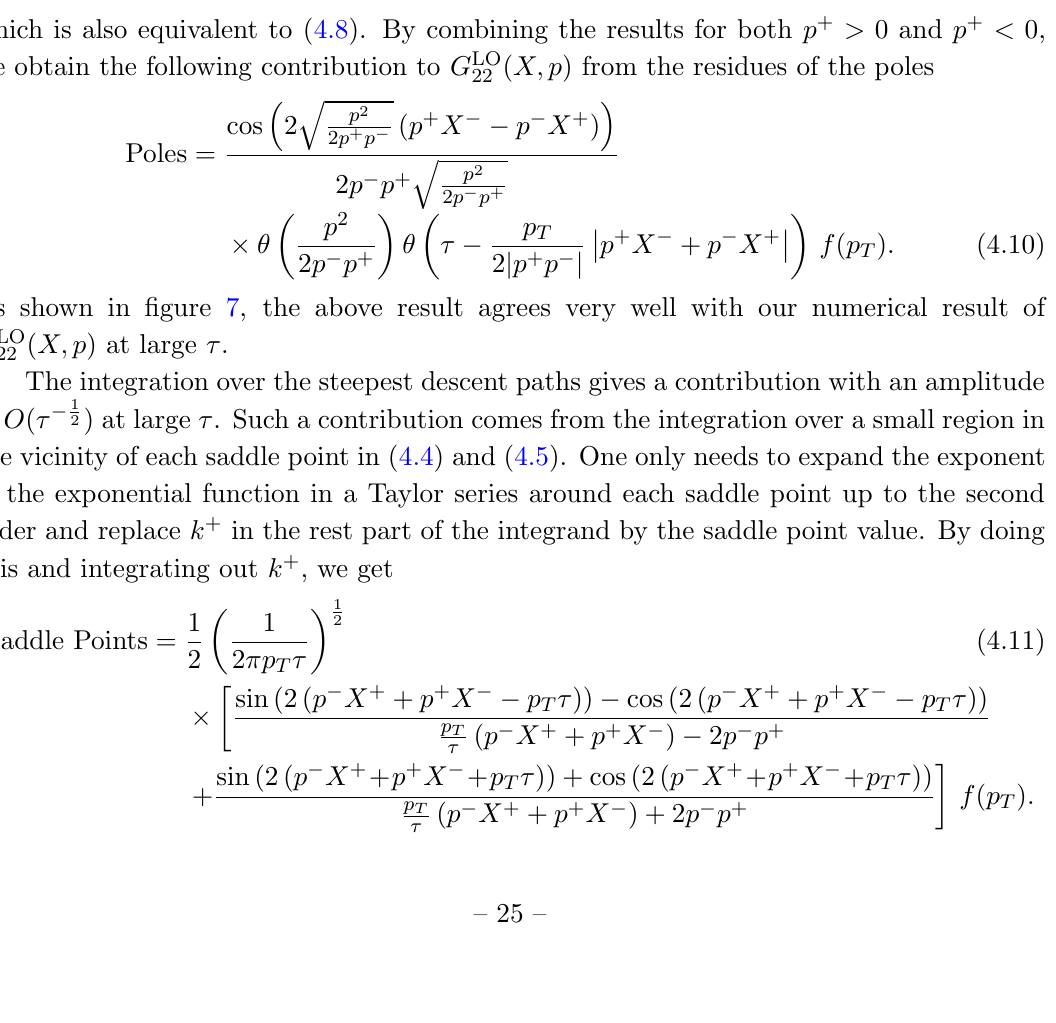
Figure 7 . Comparison with the numerical calculation of G LO analytical result in (4.10) (Poles), the sum of (4.10) and (4.11) (Poles+Saddle) and our numerical result (Numerics) at X + = X (cid:0) = 200. The bottom (cid:12)gure shows our result from poles (Poles)